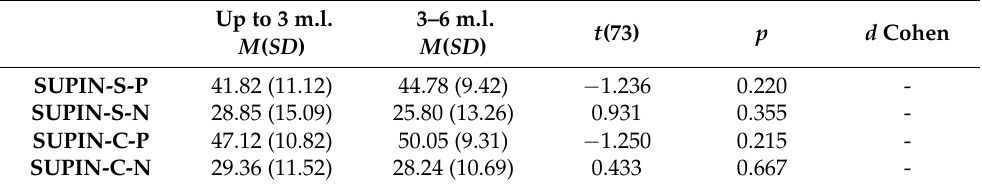
Table 7. The differences between the intensity of positive and negative emotions of first-time mothers taking into consideration the age of children.